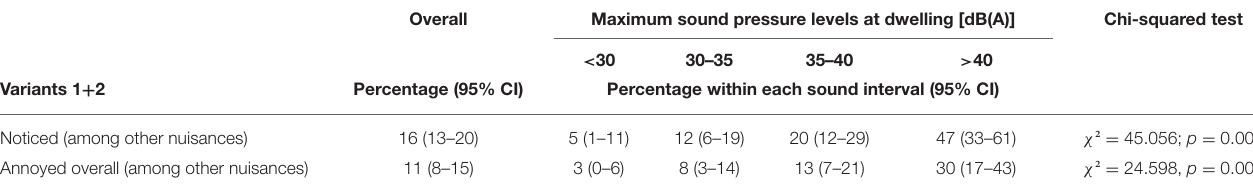
TABLE 1 | Annoyance with wind turbine noise (WTN) related to sound exposures is shown as the percentage within each sound interval with 95% CI. Overall Maximum sound pressure levels at dwelling [dB(A)] Chi-squared